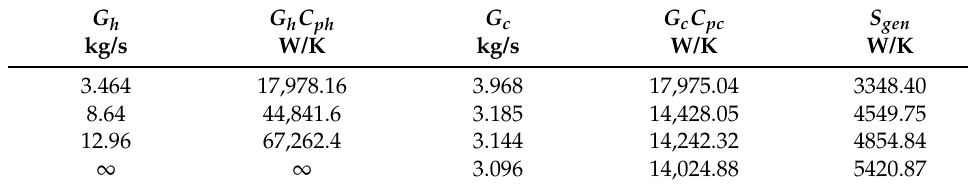
Table 5. Heat capacity rates of the streams and respective total entropy